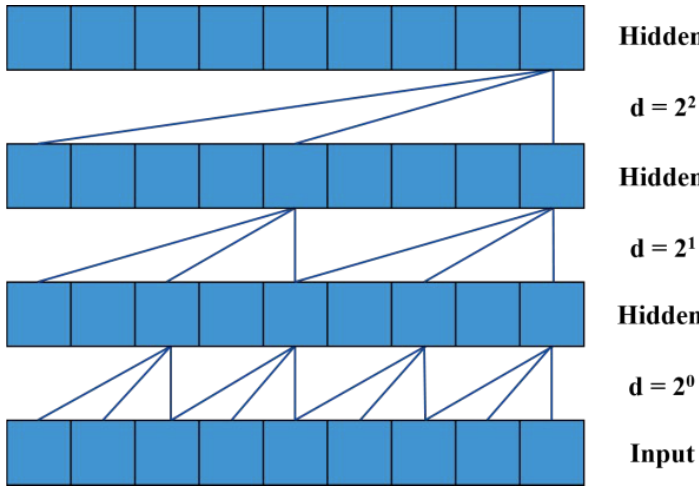
Figure 11. Structure of the Temporal Convolution Layer.